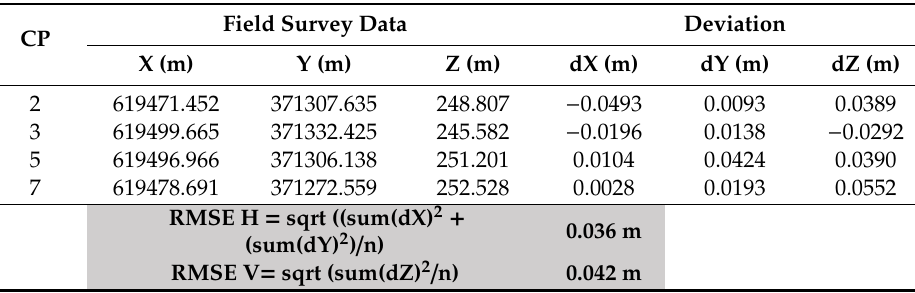
Table 3. UAV-SfM model accuracy assessment